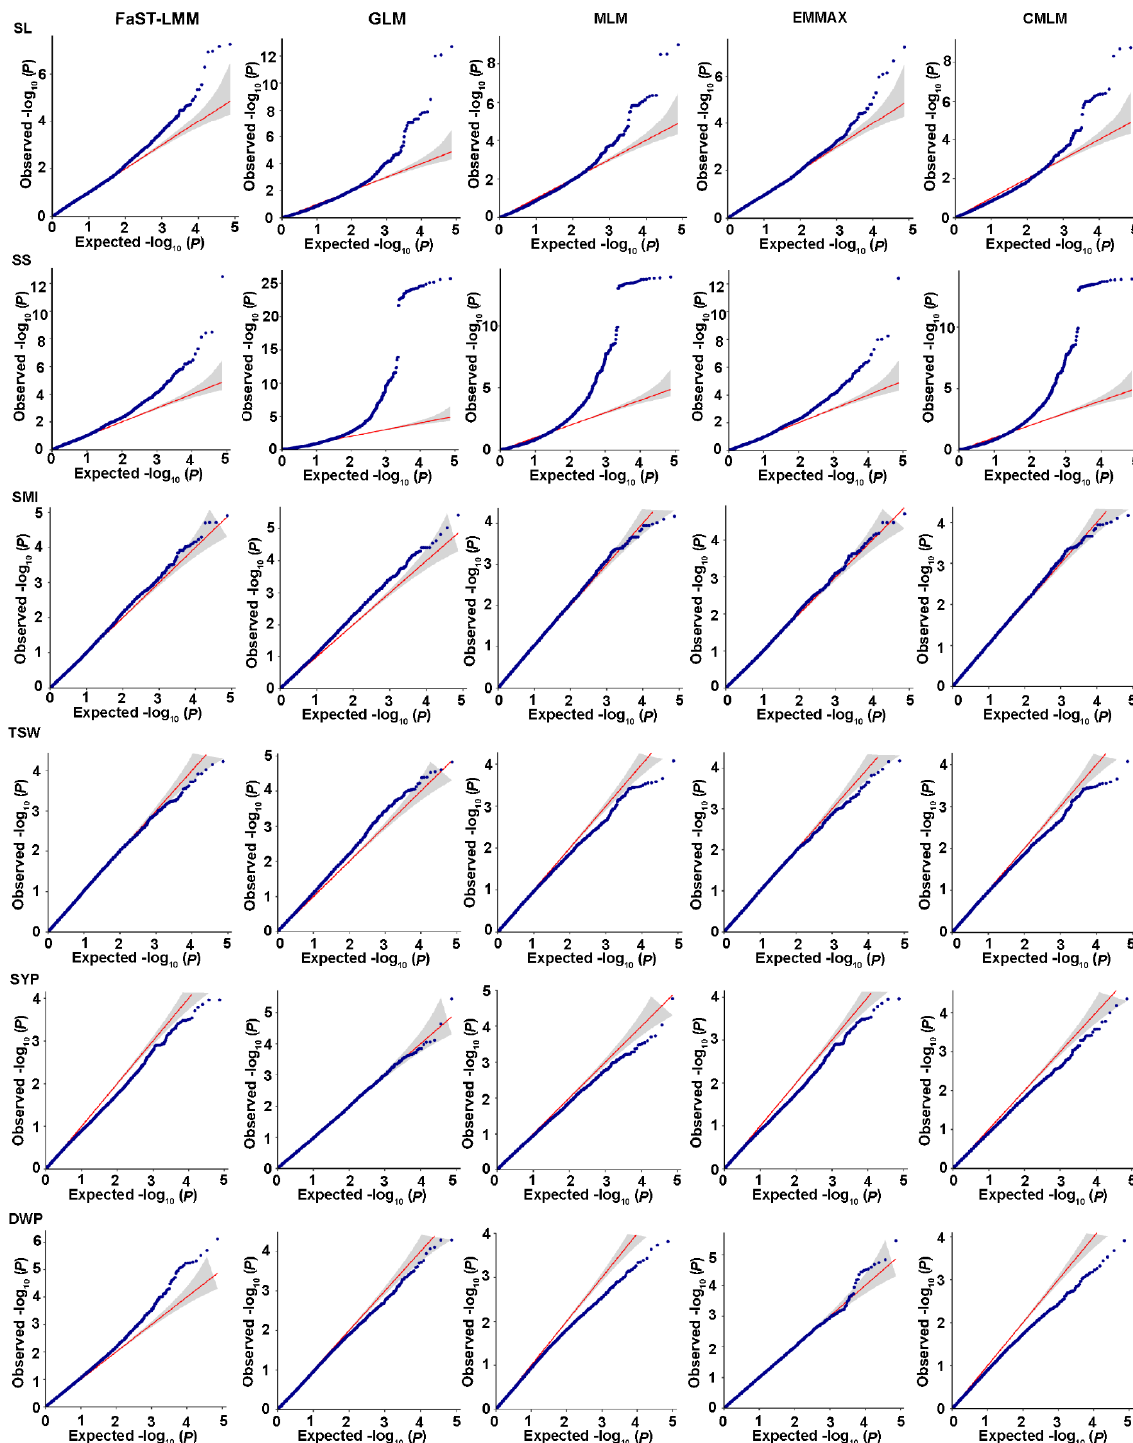
Figure 5. Quantile-quantile plots from association analysis of six yield-related traits. The red line represents the 45° centerline, and the gray area is the 95% confidence interval of the scattered points. GLM, general linear model; MLM, mixed linear model; FaST-LMM, factored spectrally transformed linear mixed model; EMMAX, efficient mixed-model association expedited; CMLM, compressed linear mixed model; SL, silique length; SMI, siliques on main inflorescence; SS, seeds per silique; TSW, thousand-seed weight; SYP, seed yield per plant; DWP, dry weight per plant. The graphs show the results in a year